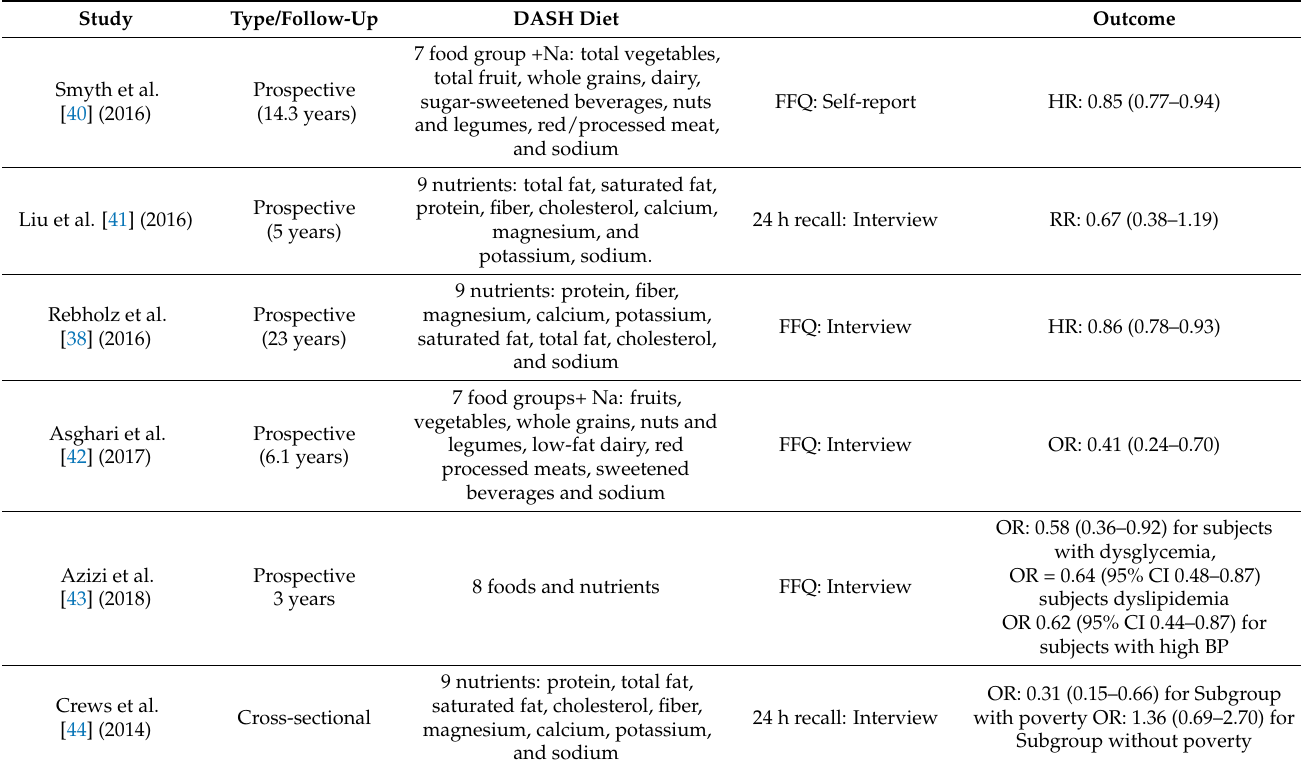
Table 3. Studies evaluating Dietary Approaches to Stop Hypertension (DASH) diet and the risk of